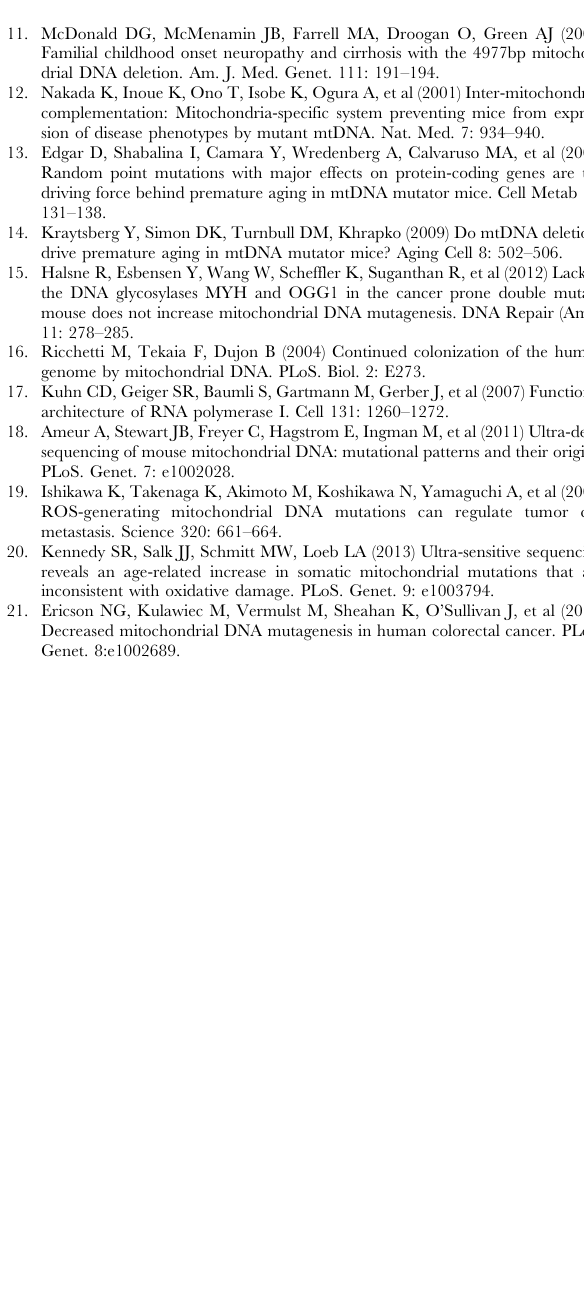
n =11) compared to young mice (1 month, n =4). Figure shows mean with SD, p** , 0.01. Figure S2 Overestimate of 28S rRNA error frequency. Errors in nuclear 28S ribosomal RNA were estimated with a slightly modified procedure. RNA was reverse transcribed, and the cDNA/RNA hybrid was treated with 100 units of TaqI for 1 h at 65 u C and followed by qPCR analysis. Figure shows mean with